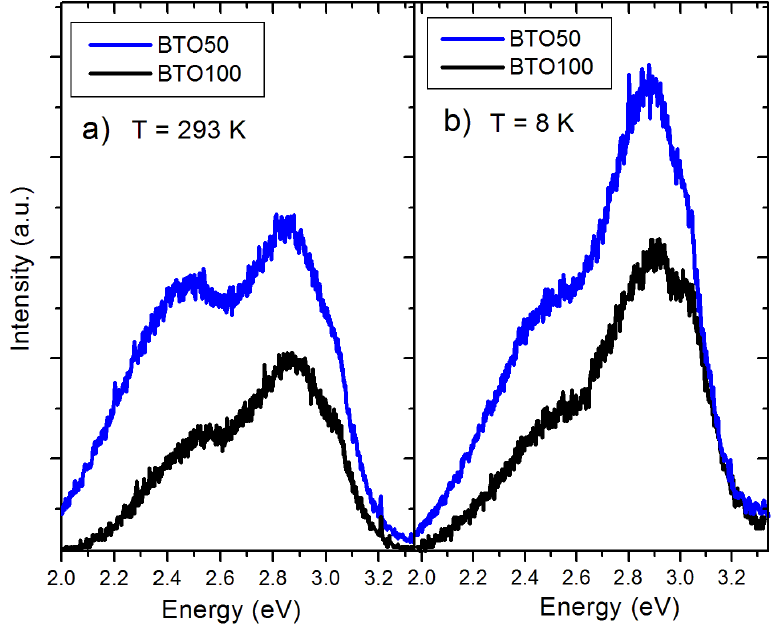
Figure 5. ( a ) Comparison of BTO50 and BTO 100 PL spectra at room temperature; ( b ) Comparison at 8 K. Note that smaller particles have greater